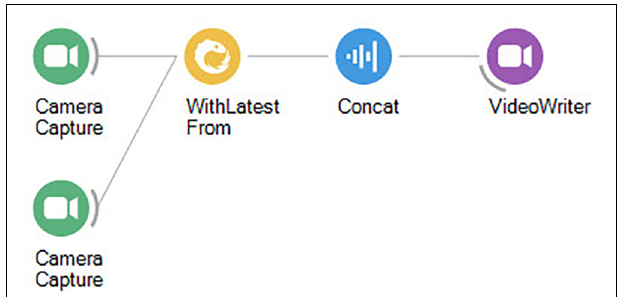
is accessible to the animal, despite freely moving conditions (Walter and Couzin, 2020).